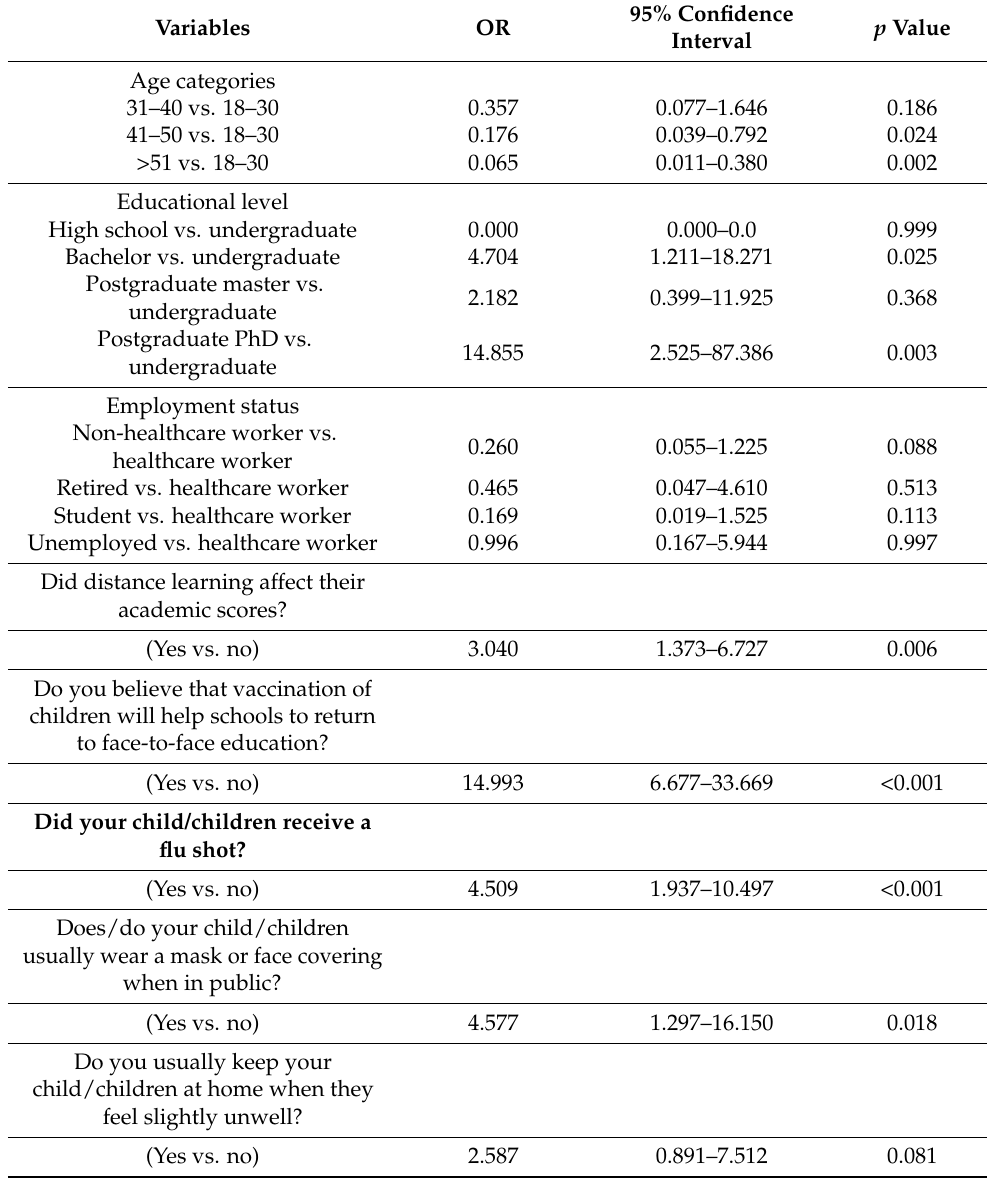
Table 8. Logistic regression taking the parents’ willingness to get their children back to school as the dependent variable and all other factors as the independent variables ( n =